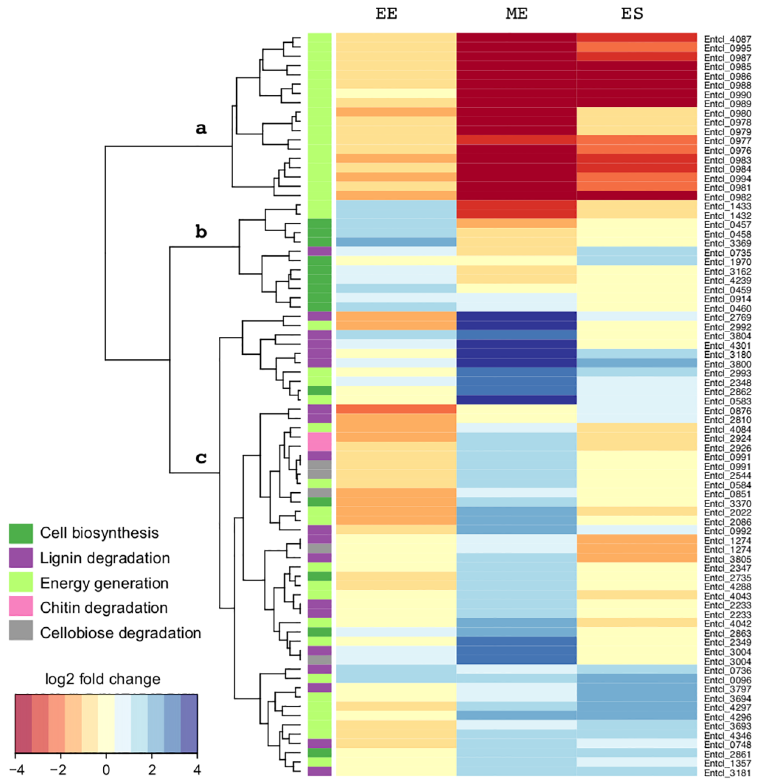
Fig 3. Clustering of transcripts shows response to lignin in genes of interest in Enterobacter lignolyticus SCF1 grown in glucose with and without lignin. Fold changeindicateschange in relative abundance of transcript in lignin-amended comparedto unamended growth. Colors to the left of the heatmap indicatefunctionalannotations as indicated.Each row represents gene expressionof cells grown in ligninand glucose,comparedto cells grown in glucosealone at the same time